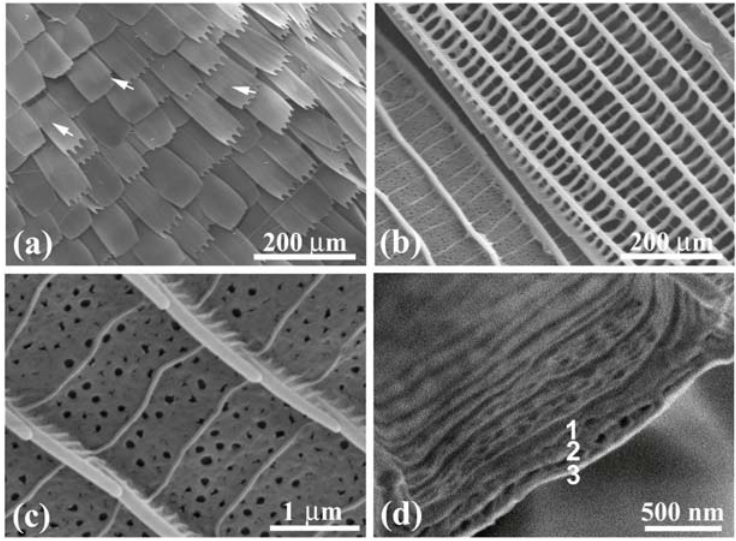
Figure 9. SEM images of the dorsal scales of the female C. ataxus . ( a ) Law-magnified image; ( b ) Ridges and cross ribs in a violet scale (left) and a dark brown scale (right); ( c ) Enlarged image of the ridges and ribs in the violet scale; ( d ) Cross-section of a groove plate enclosed by the ridges and ribs, revealing triple piled layers (adapted from